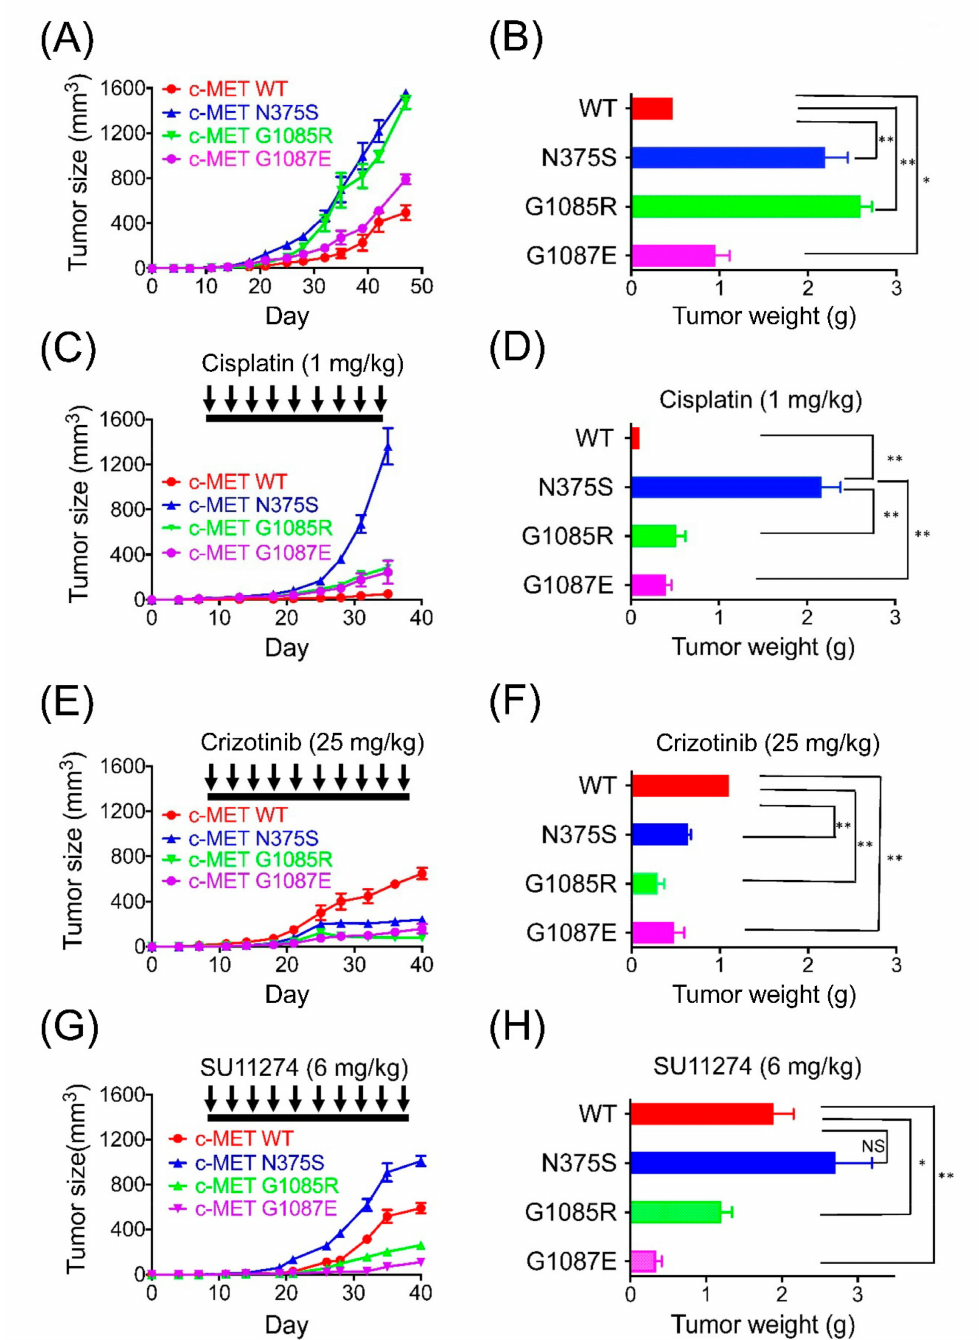
Figure 3. Antitumor effects of cisplatin and tyrosine kinase inhibitors in endometrial cancer xenografts harboring different MET mutations. 1 × 10 6 RL95-2 cells carrying wild-type or mutant MET , including N375S, G1085R, and G1087E, were injected into the posterior flank of SCID mice subcutaneously. The tumors were allowed to grow and were treated by observation only ( A , B ), cisplatin (1 mg/kg) twice a week ( C , D ), crizotinib (25 mg/kg) by oral gavage twice a week ( E , F ), or SU11274 (6 mg/kg) twice a week ( G , H ) ( n = 5 in each treatment group). Tumor size and body weight were measured twice a week. Data are presented as the mean tumor size ± SEM. *, p < 0.05; **, p < 0.01; NS,